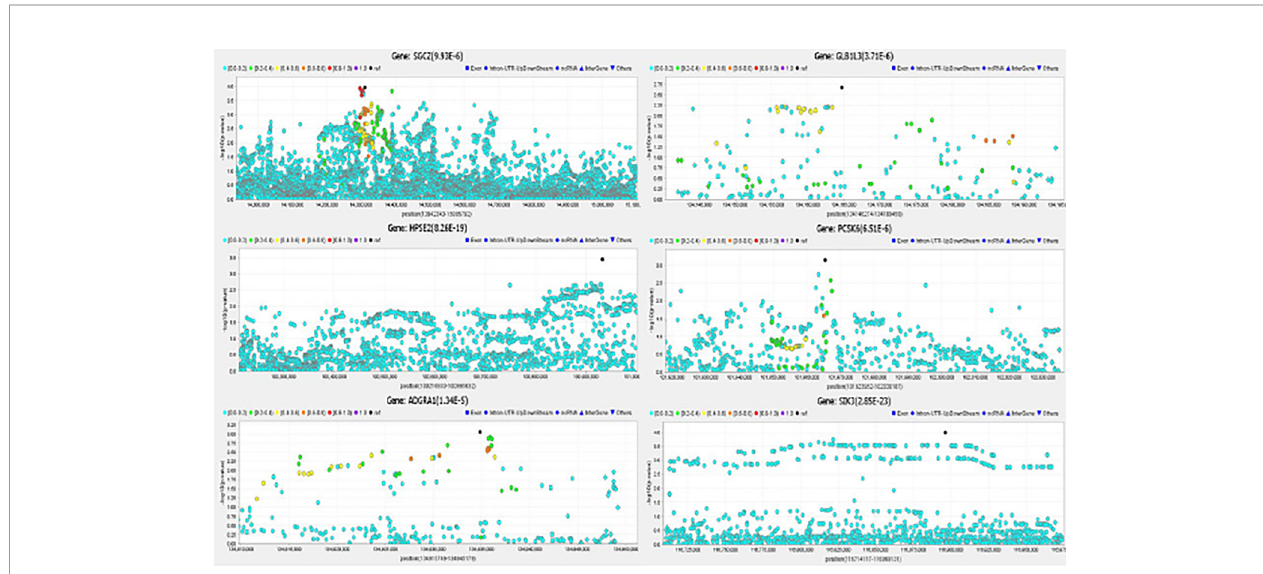
FIGURE 7 | Regional Association Plots for Signi fi cant